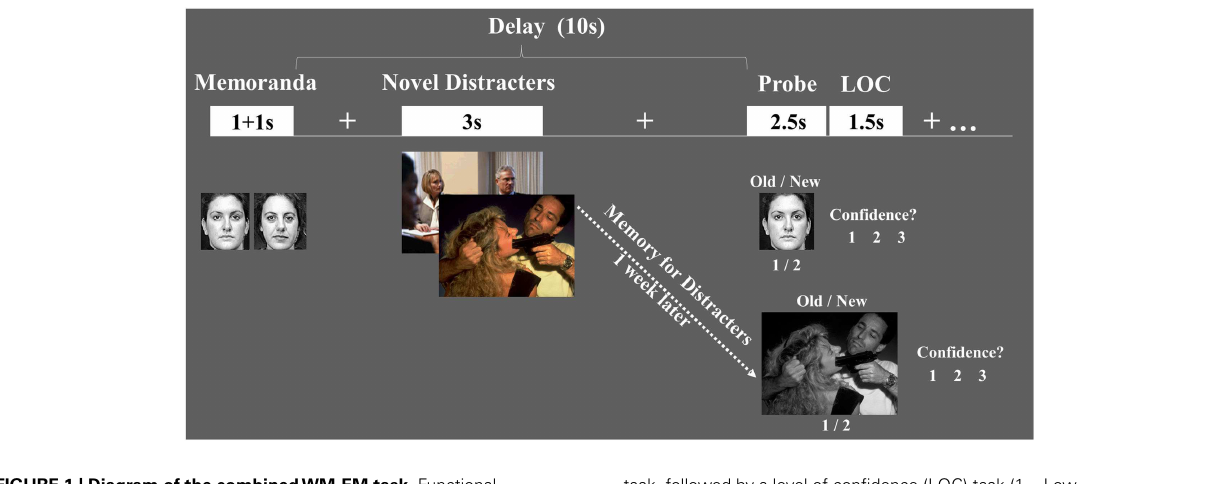
task, followed by a level of confidence (LOC) task (1 = Low, 2 = Medium, 3 = High). EM for the distracters themselves was measured 1-week later, outside the scanner, and also involved Old/New and LOC